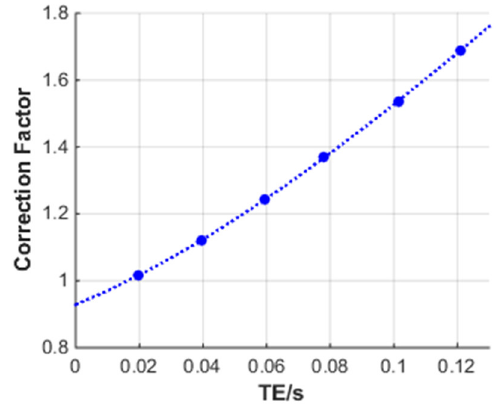
Figure 5. Cascade plot for trailing edge thickness loss correction factor.